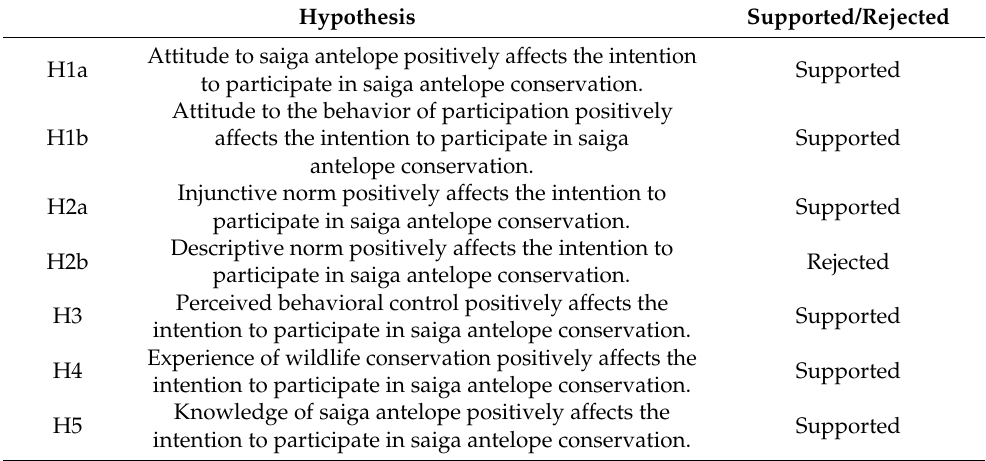
Table 5. Summary of hypothesis